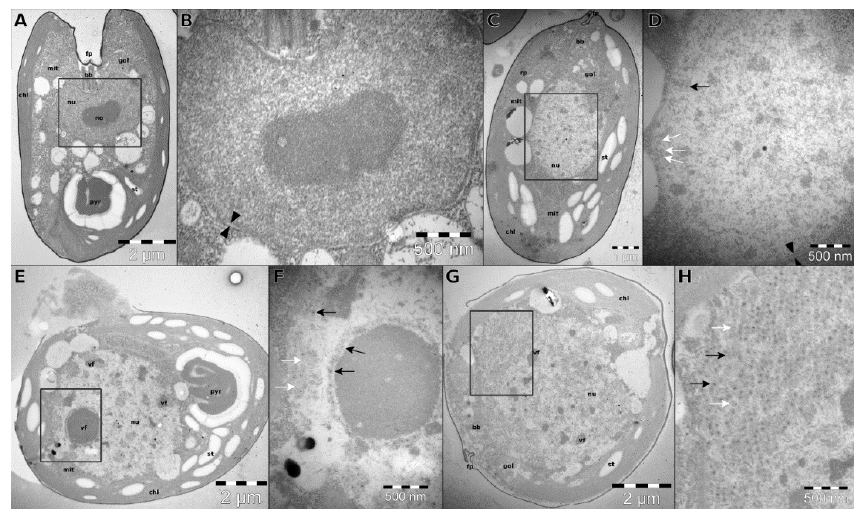
Figure 3. Ultrastructural changes in T. striata associated with the progression of TsV-N1 infection. ( A ) longitudinal section of an uninfected cell, with anterior flagellar pit and posterior pyrenoid; ( B ) nucleus of an uninfected cell, view corresponding to the frame in (A); ( C ) longitudinal section of an infected cell, first noticeable changes; ( D ) detail of the nucleus corresponding to the frame in (C); first viral capsids, intact nuclear envelope. ( E ) Longitudinal section of an infected cell with highly disordered nucleus; ( F ) enlargement of frame in (E) showing a viral factory (vf) inside the nucleus; ( G ) longitudinal section of a cell at the final stage of infection; ( H ) enlargement of frame in (G) showing numerous viral particles. Facing black arrowheads (B,D) nuclear envelope. Black and white arrows (D,F,H) full and empty viral particles. Legend: bb, basal bodies; chl, chloroplast; fp, flagellar pit; gol, golgi apparatus; mit, mitochondrion; no, nucleole; nu, nucleus; pyr, pyrenoid; rp, rhizoplast; st, starch grain; and vf, viral factory.